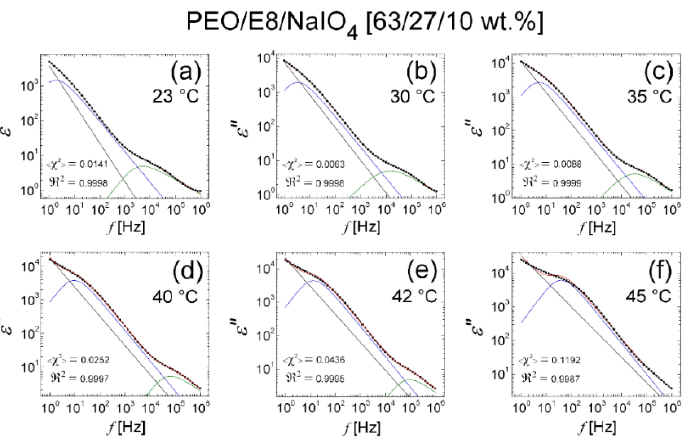
Figure 15. Dielectric spectra ε (cid:48)(cid:48) ( f ) of PEO/E8/NaIO 4 composite at various temperatures in the range of 23 ◦ C ( T room ) to 45 ◦ C (slightly above T g = 42.5 ◦ C): 23 ◦ C ( a ); 30 ◦ C ( b ); 35 ◦ C ( c ); 40 ◦ C ( d ); 42 ◦ C ( e ); 45 ◦ C ( f ). The ε (cid:48)(cid:48) spectral data are represented by the symbol (X); the lines are the best fits to the ε (cid:48)(cid:48) data with the use of fitting function in Equation (2) (KWW + HN model). The curves represent the two resolved (decomposed) peaks of the dielectric relaxation response in the ε (cid:48)(cid:48) ( f ) spectrum, resulting from the KWW function (blue) and the HN function (green), respectively; the straight line represents the contribution of the conductivity term; the envelope of the three spectral components’ curves (the total fit) is colored in red. As quality measures of each obtained fit, the values of the reduced < χ 2 > factor (the coefficient of determination by fit), as well as the regression coefficient of fit), are also